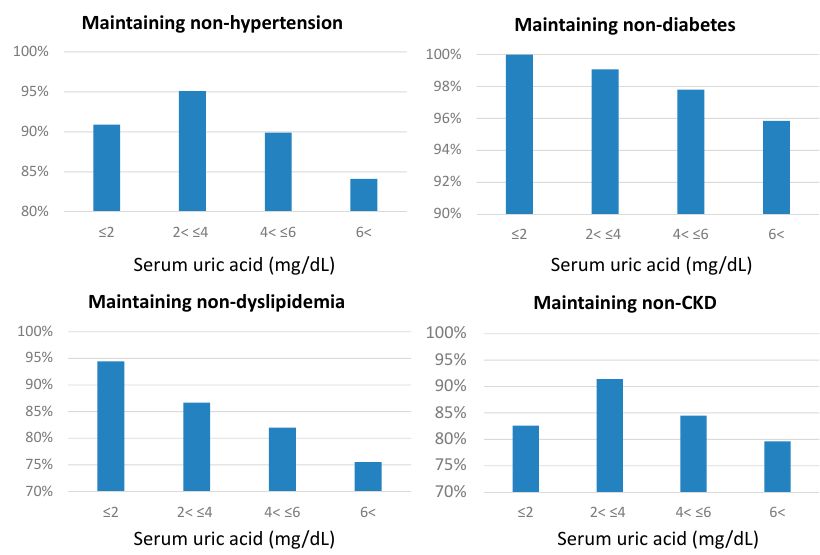
Figure 4. Maintaining rate of lacking hypertension, diabetes, dyslipidemia, and chronic kidney disease among four serum urate categories over five years. CKD, chronic kidney